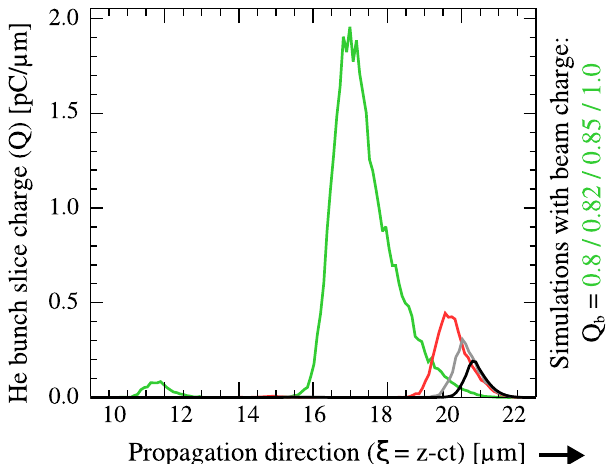
FIG. 6. Plot of the slice charge longitudinal density profile of the trailing beams injected via B-III near the back of the bubble at the end of the simulations, ct ¼ 6 cm, performed with driver charges of 0.8, 0.82, 0.85, and 1 nC. Longitudinal axis corre- sponds to the comoving variable, ξ ¼ z − ct , and the propagation direction is from left to right side of the